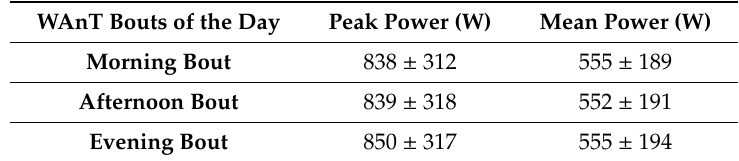
Figure 5. Normalized changes (mean ± SD) in maximum voluntary contraction (MVC) of the dominant lower limb on isokinetic dynamometer at knee extension at velocity of 30°·s −1 and 300°·s −1 , and knee flexion at velocity of 30°·s −1 and 300°·s −1 , from baseline (0%) to post-6 weeks training for non-training or control (CON , N = 17) group and intervention training (INT; N = 16) group. * Significance ( p < 0.05) difference from CON group. Effect size ( d ) for the difference between CON and INT groups is shown on the top of the graph. Table 4. The average peak and mean power of the morning, afternoon and evening 30-s Wingate Anaerobic cycle test (WAnT) bouts performed throughout the six-weeks training period.